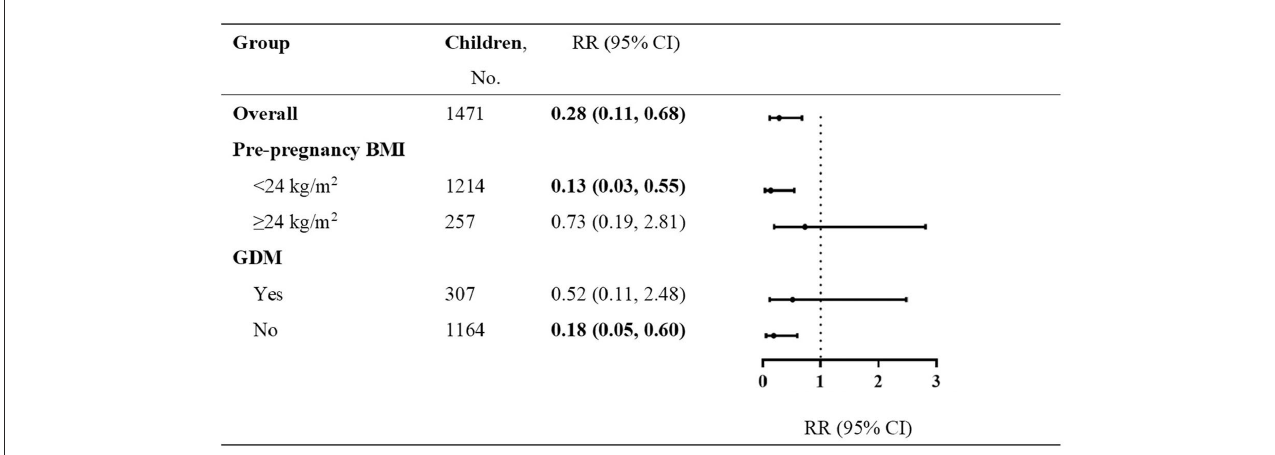
FIGURE2 Communication domain failure in infants born to mothers with low Mediterranean diet score vs. high Mediterranean diet score. RR with 95% CI for the dichotomous outcomes of communication domain failure is for Mediterranean diet score during pregnancy (4–7 vs. 0–3). Adjusted confounders included maternal age, education, household income, blood pressure (systolic and diastolic), anemia during pregnancy, depressive symptoms, maternal physical exercise, the supplement of nutrients, such as vitamin D, folic acid, and iron, pregnancy history, delivery mode, gender, gestational week, k, birth weight, and the patterns of infant